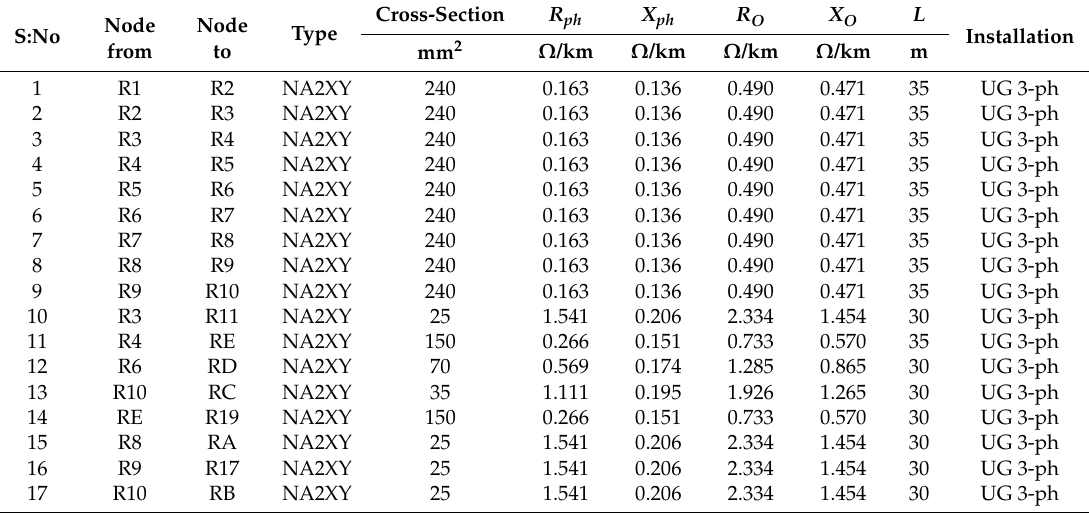
Table A2. The detailed information of different cables/lines used in the